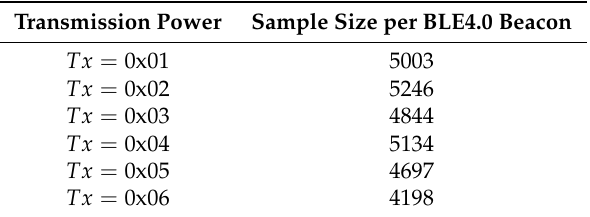
Table 2. Sample sizes of the RSSI captured using the BLE4.0 at various transmission power ( Tx ) levels.